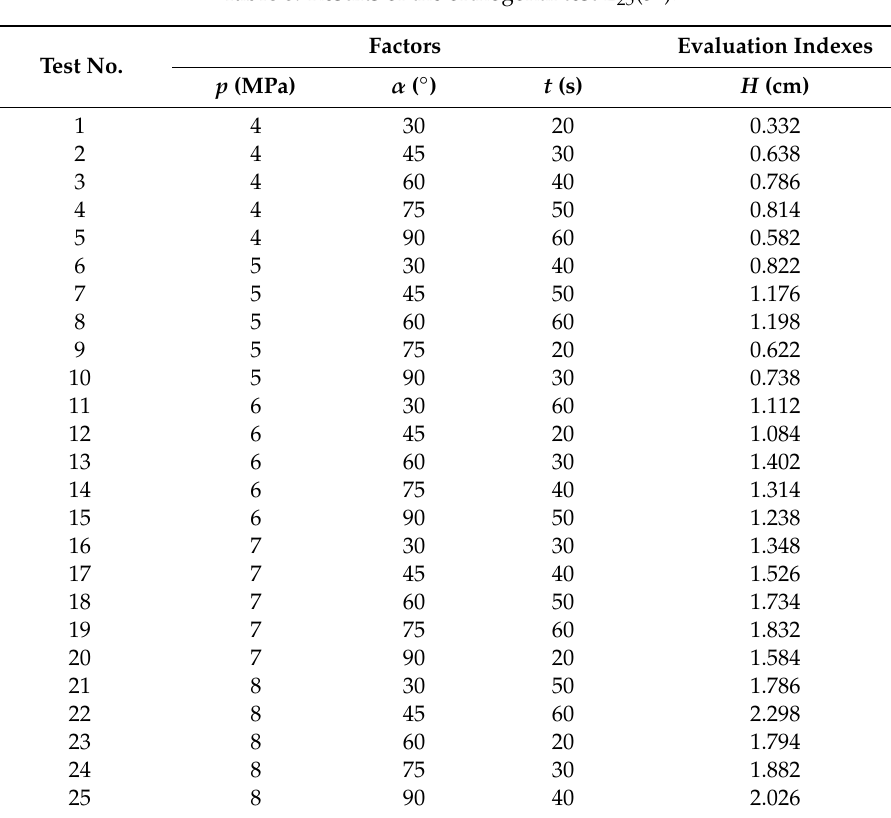
Table 8. Results of the orthogonal test L 25 (5 3